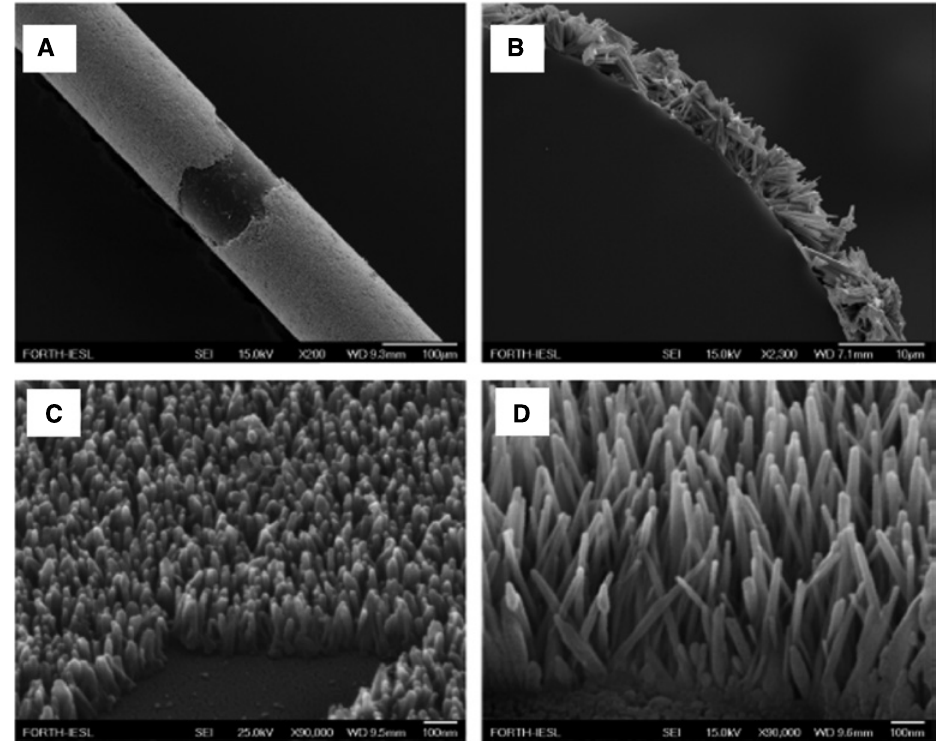
Figure 6: SEM images of ZnO nanorod layer grown onto a silica fiber surface. Large view (A) and cross-section (B) of the coating after 3-h immersion in ACG solution. Close view of the same overlay after 27 min (C) and 58 min (D) of chemical growth. Figures adapted with permission from Ref. [41]. Copyright (2012)